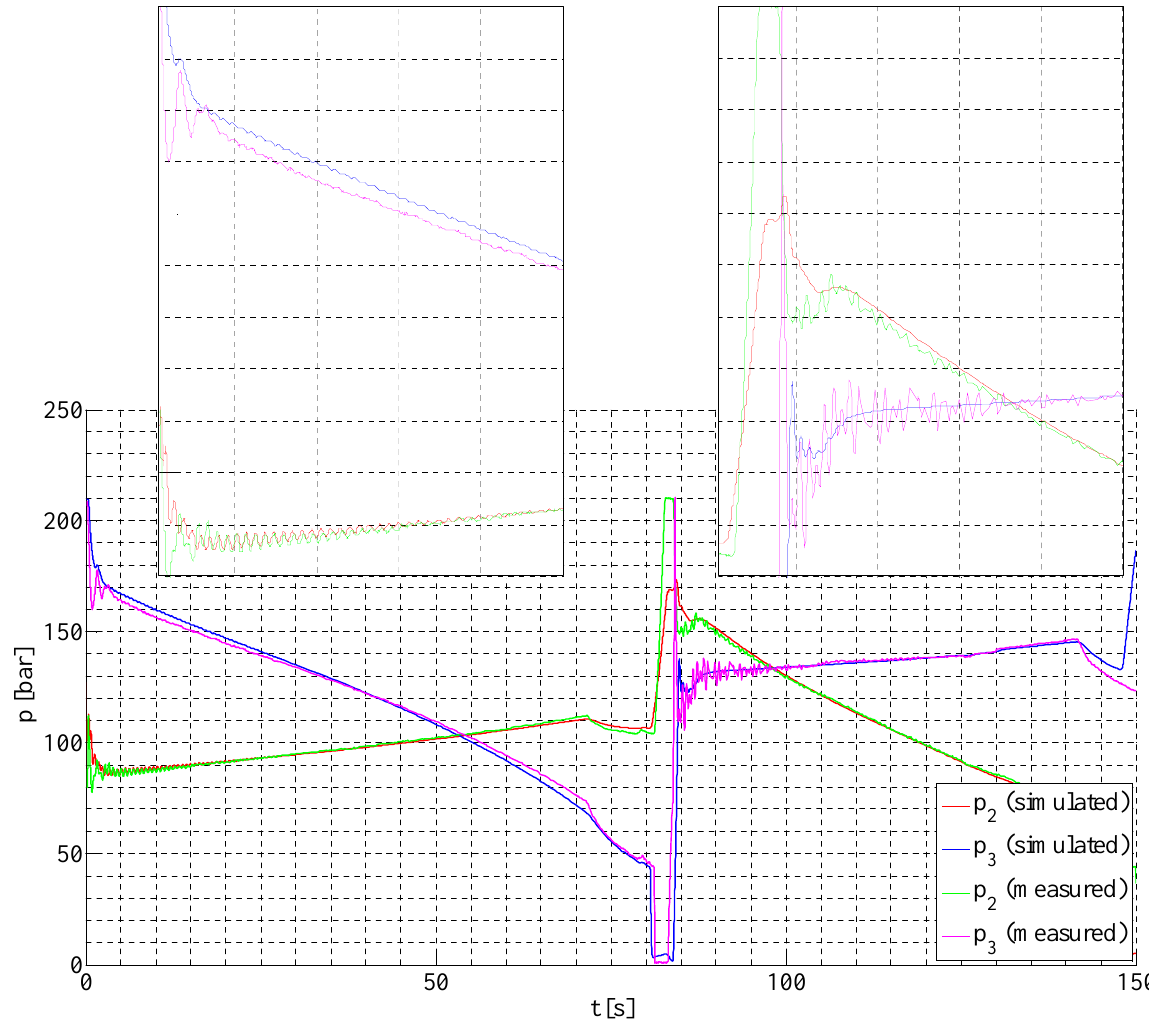
Figure 19: Measured and simulated pressures for verification of dynamic